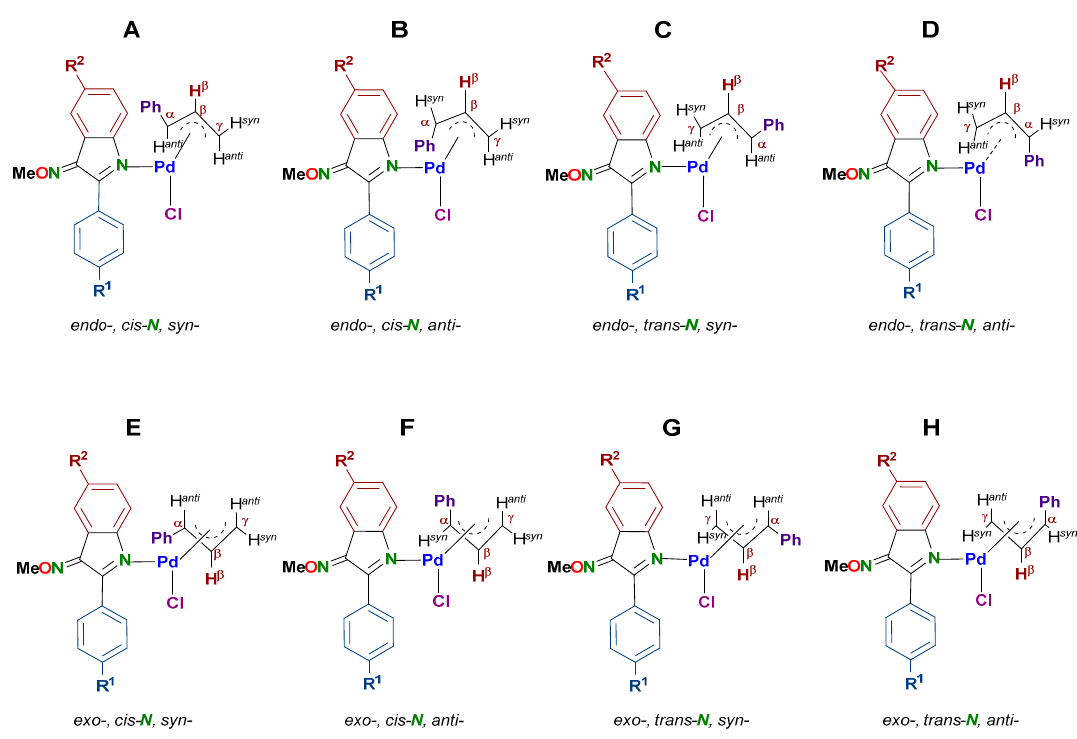
Figure 3. Schematic view of the different isomeric forms ( A–H ) of compounds 3a–3c . [R 1 = H, R 2 = OMe ( 3a ); R 1 = R 2 = H ( 3b ) or R 1 = Cl and R 2 = H ( 3c )], showing the relative arrangement of: a) the central C β -H β bond of the allylic ligand in relation to the phenyl ring (depicted in deep red) of the indole bicycle ( endo- or exo- ); b) the substituted carbon of the 1-Ph-C 3 H 4 unit and the indole nitrogen ( cis-N , or trans-N ) and c) the phenyl ring of the allyl ligand in ( syn - or anti- ) in relation to the H β atom. Table 1. Crystal data and details of the refinement of the crystal structures of compounds [Pd( η 3 -1- R 3 C 3 H 4 ){C 8 H 3 N-2-(C 6 H 4 -4-R 1 )-3-NOMe-5-R 2 }Cl] with R 3 = H, R 2 = OMe ( 2a ); R 3 = Ph, R 2 = OMe and R 1 = H ( 3a ) and R 2 = R 1 = H ( 3b ).